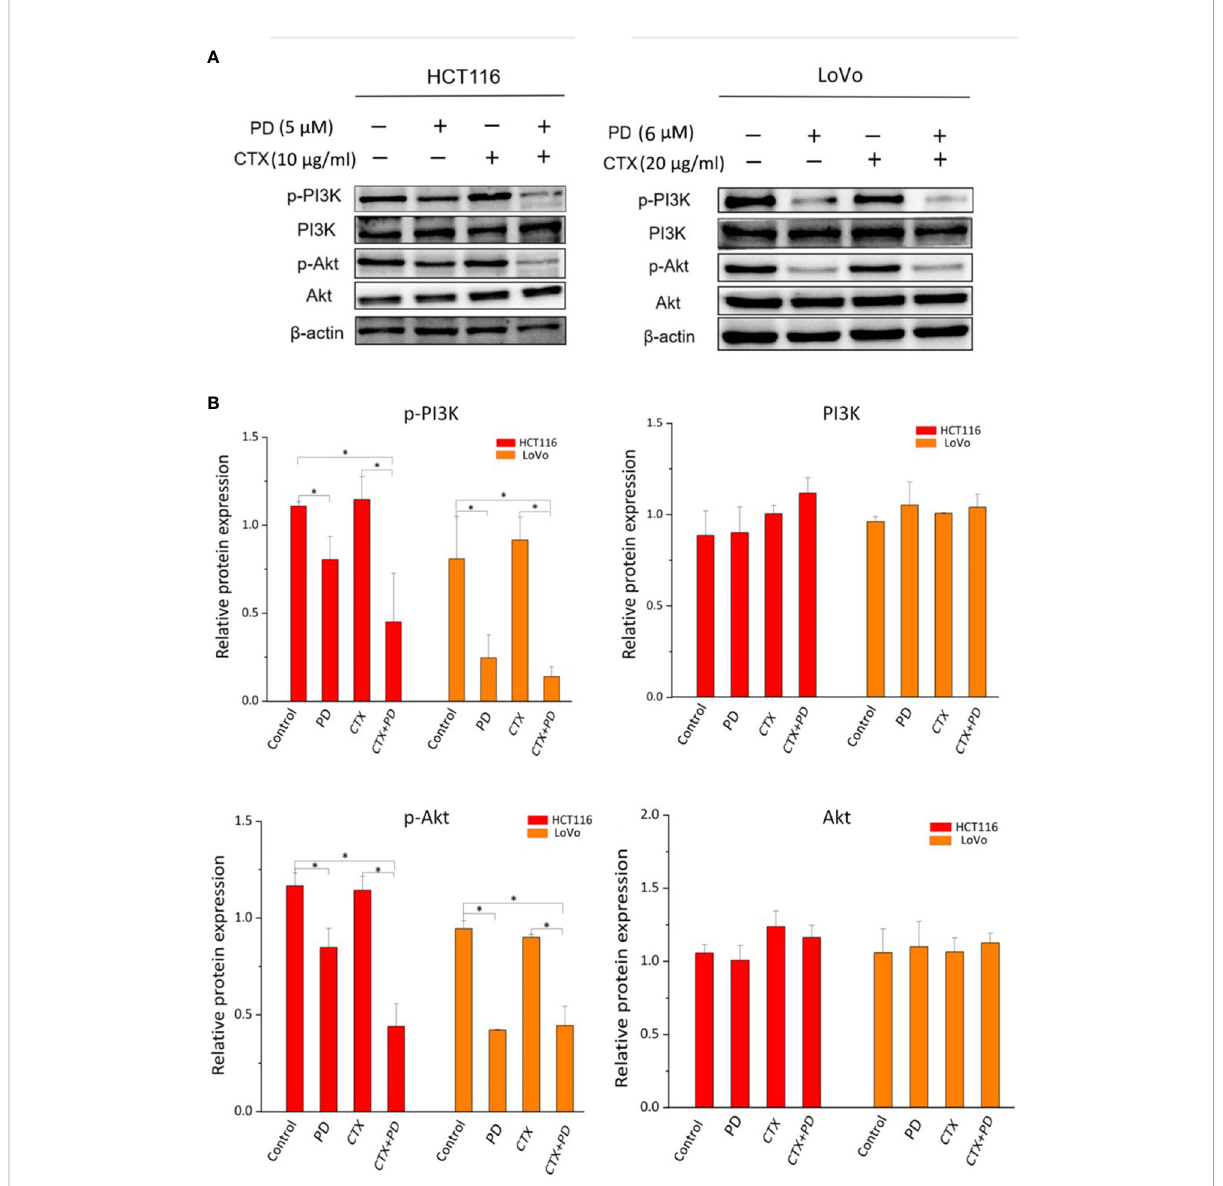
FIGURE 2 Western blotting analysis of PI3K and Akt in PD- and CTX-treated cells. (A) Western blot images. The left column shows protein names, including p-PI3K, PI3K, p-Akt, Akt, and b -actin, which was used as loading control. The top row shows two cell lines HCT116 and LoVo, and drug treatment with different combinations. (B) Bar plots of densitometric analysis. Protein expression levels are normalized to that of the loading control. Columns show the mean ± S.D. One-way ANOVA was used to analyze P values between groups. All groups are compared with the ‘ Control ’ group, the ‘ CTX ’ group is compared with the ‘ CTX+PD ’ group. * P < 0.05 represents a signi fi cant